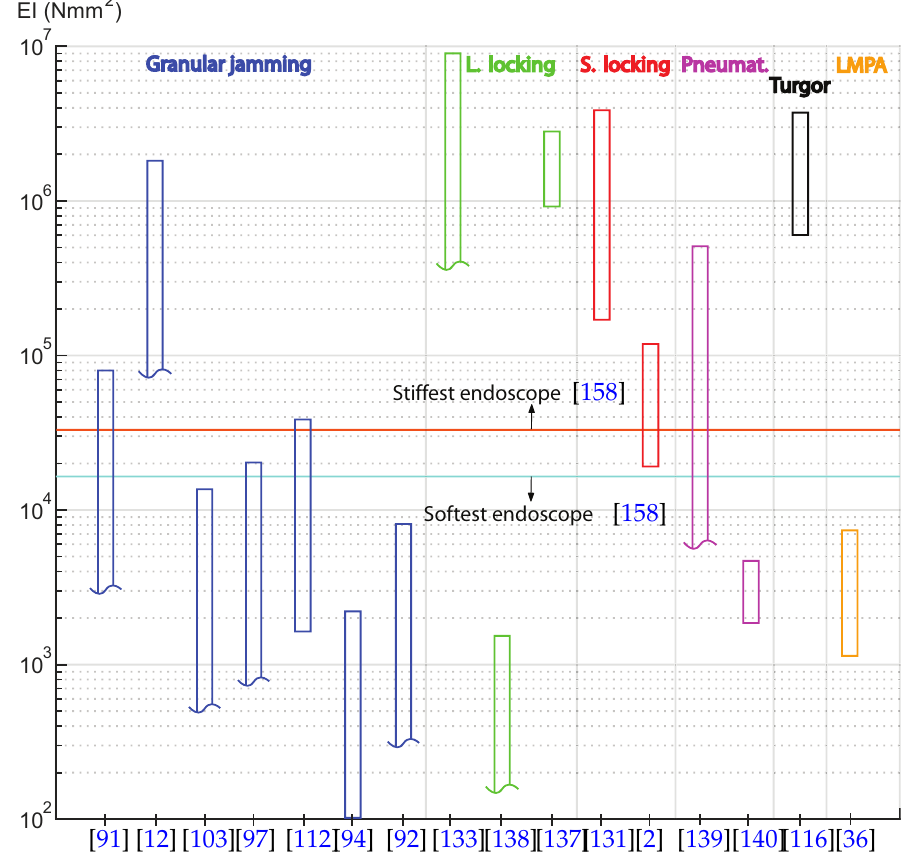
Figure 7. Comparison of various endoscopic-like solutions based on their bending stiffness. The performances of the solutions are compared with current endoscopes. The upper limit of bending stiffness corresponds to the stiffest endoscope on the market, and the lower limit corresponds to the softest one (pediatric type). “L. locking” stands for “Longitudinal locking”, “S. locking” for “Segments locking”, “Pneumat.” for “Pneumatic solutions”, “Turgor” for “Turgor pressure” and “LMPA” for “Low Melting Point